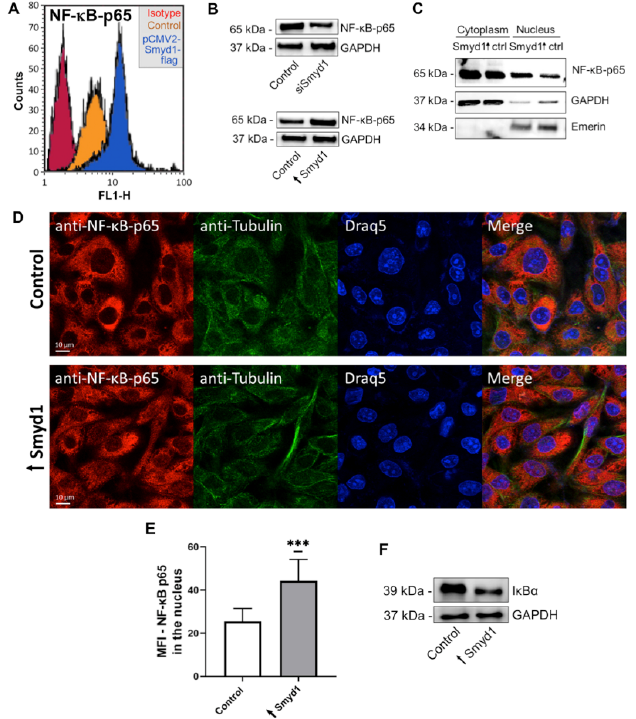
Figure 3. Smyd1 up ‐ regulates and activates nuclear translocation of NF ‐κ B in EA.hy926 cells. ( A ) Representative flow cytometry histograms of EA.hy926 cells transfected with a pCMV2 ‐ Smyd1 ‐ flag vector or a vector without gene insert (control) and incubated with a monoclonal antibody recognizing the p65 subunit of NF ‐κ B and, subsequently, fluorescence ‐ labeled secondary antibodies. An isotype ‐ matched monoclonal IgG control antibody was used as control. ( B ) Immunoblotting for the determination of NF ‐κ B ‐ p65 levels in total lysates of EA.hy926 cells transfected either with a vector lacking a specific gene insert (Control) or a pCMV2 ‐ Smyd1 ‐ flag vector ( ↑ Smyd1) and scrambled siRNA (Control) or Smyd1 ‐ specific siRNAs (siSmyd1). Representative immunoblots of n = 3. ( C )